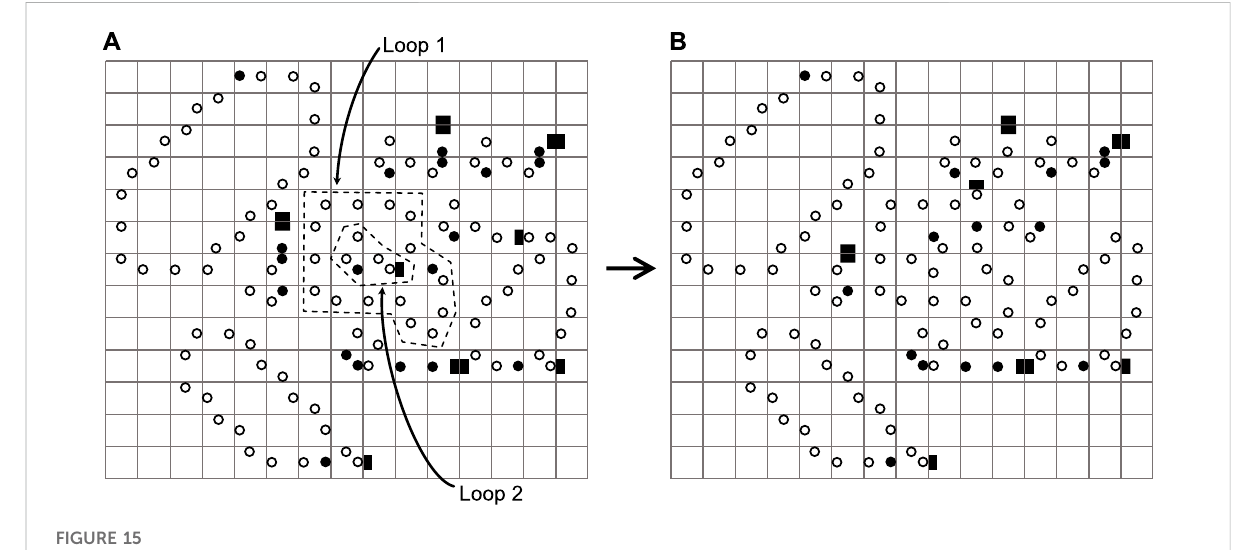
FIGURE 15 A phagocytosis situation because of different self-replicating